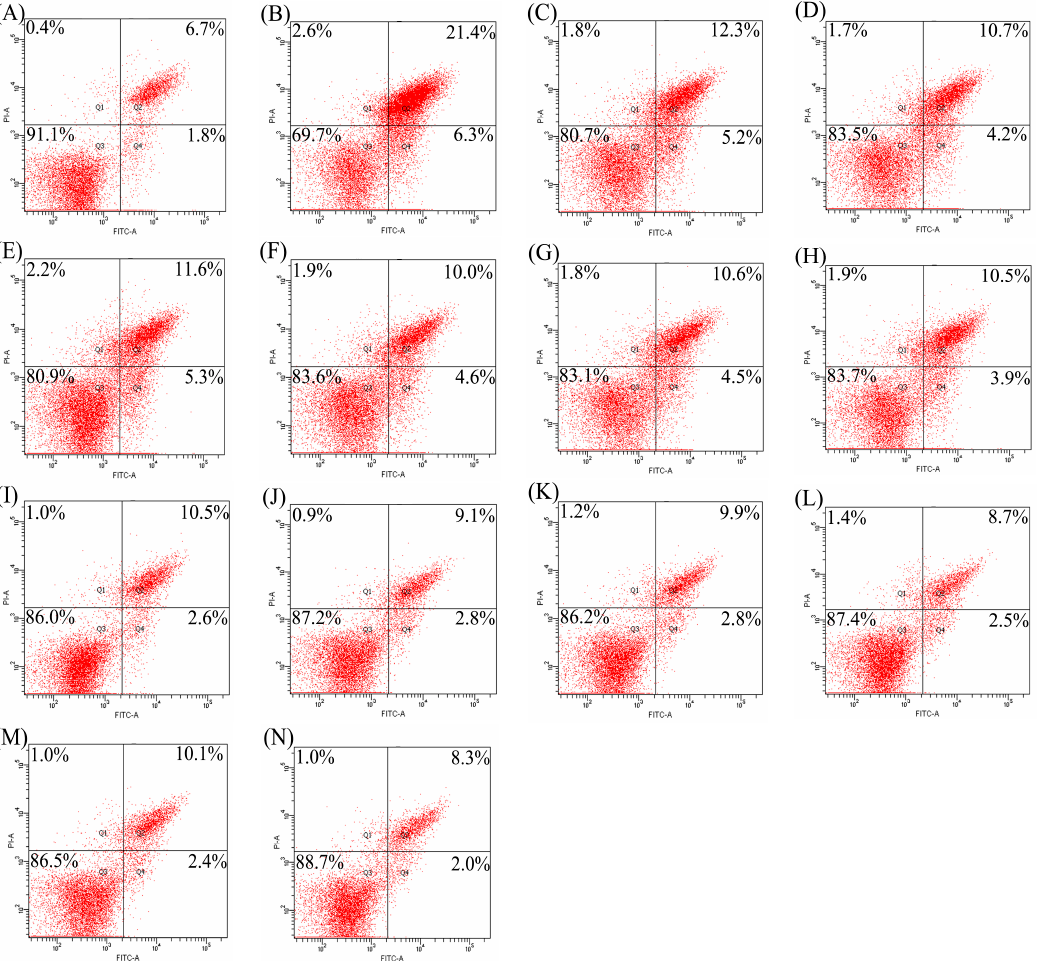
Figure 1. Detection of apoptotic prevention in the osteoblasts by flow cytomety. ( A ) control cells; ( B ) cisplatin-treated cells; ( C – H ) the cells firstly treated by respective PAH1, PAH3, PNH1, PNH3, PPH1, and PPH3 for 48 h, and then treated by cisplatin for 24 h; ( I – N ) the cells firstly treated by TAH1, TAH3, TNH1, TNH3, TPH1, and TPH3 for 48 h, and then treated by cisplatin for 24 h.